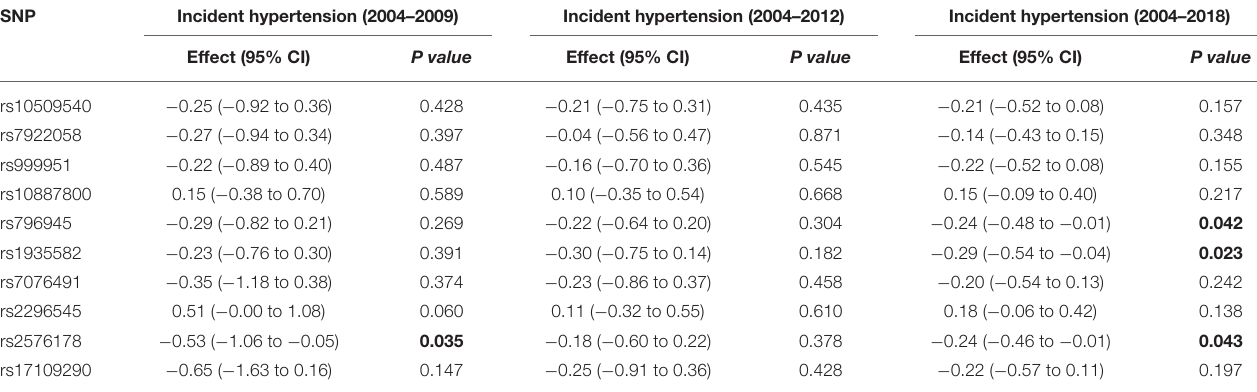
TABLE 4 | Association of individual SNPs with hypertension